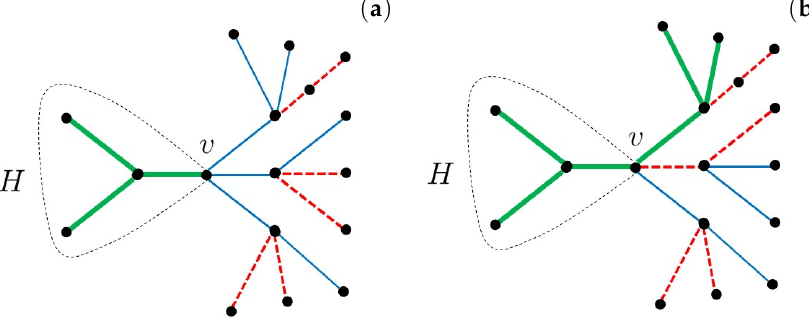
+ φ 2 + φ 3 a , b a , b a , b